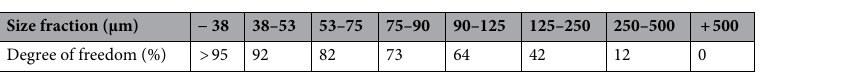
Table 2. Degree of freedom for different size fractions.